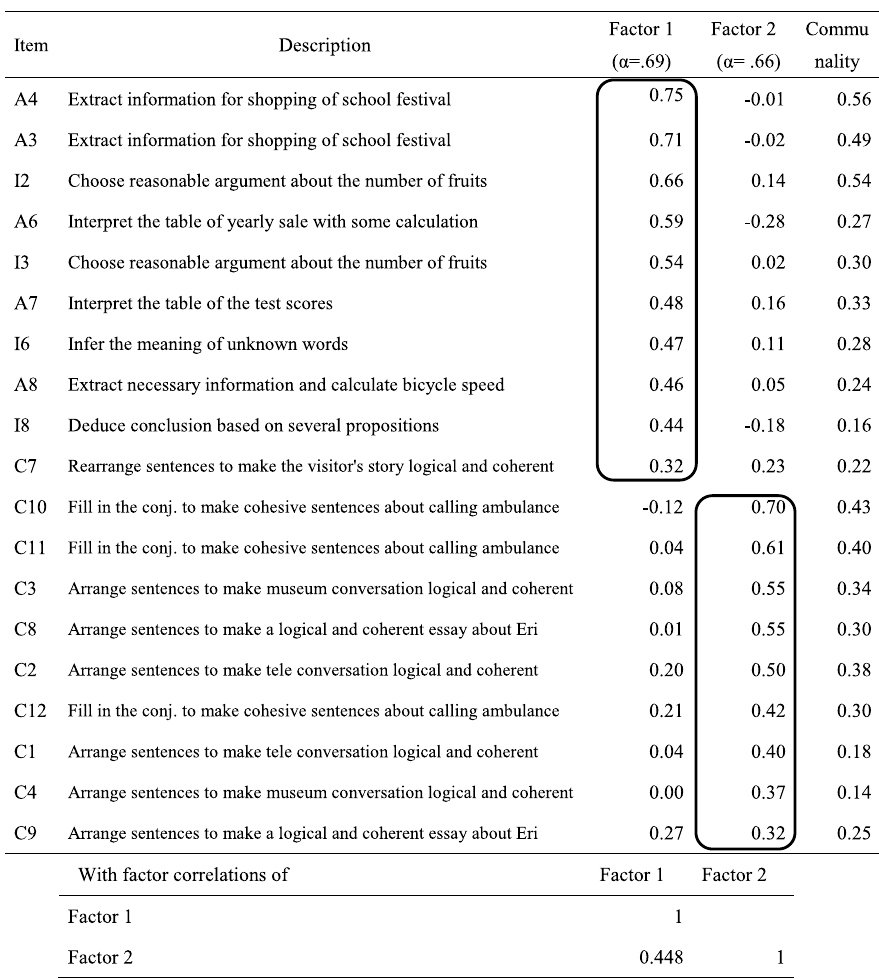
Table 6 Exploratory factor analysis of